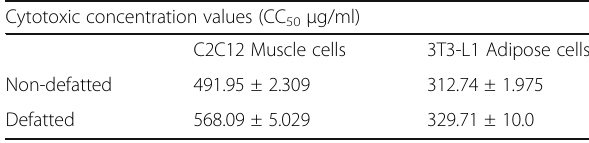
Table 3 Cytotoxic concentration killing 50% of cells Cytotoxic concentration values (CC 50 μ